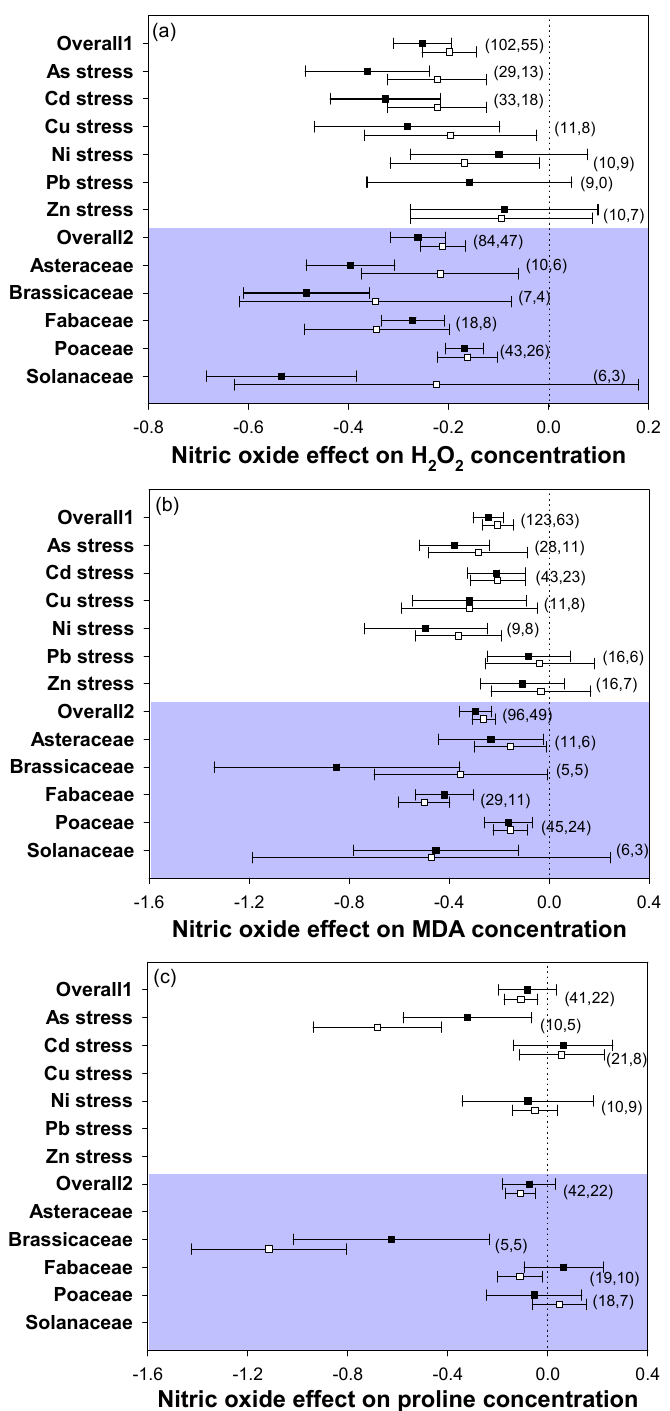
Figure 2. Plots of effect sizes for the effect of NO on oxidative stress markers in heavy metal-stressed plants, including ( a ) H 2 O 2 concentration, ( b ) MDA concentration, and ( c ) proline concentration. Overall1 and overall2 indicate the mean (summary) effect size of all metal stresses and plant families, respectively. Black and white dots indicate the mean effect sizes for factor groups of leaf and root responses, respectively. The numbers in brackets specify the number of data points. The black square block with the error bar indicates the mean response size with a 95% confidence interval, and the dashed vertical line shows zero effect.